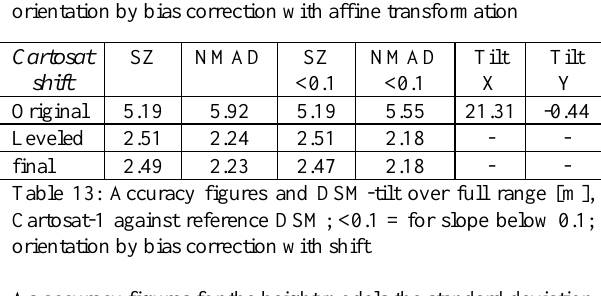
Figure 7. Systematic height errors in X-direction, Saintes-